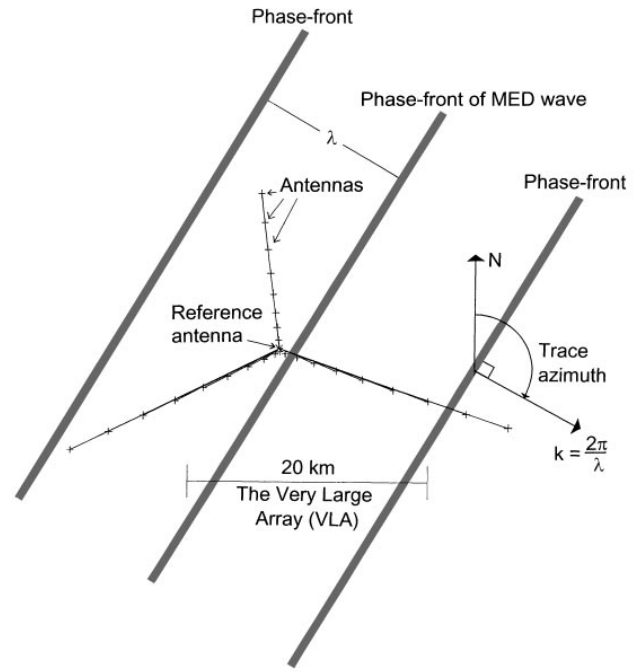
Fig. 1. Idealized sketch of the VLA and a MED wave passing across the array. The trace azimuth is shown as the angle clockwise from north, and the wave vector, k , is defined to be equal to 2 (cid:112) = (cid:107) in the direction of the trace azimuth. Note the spatial scale